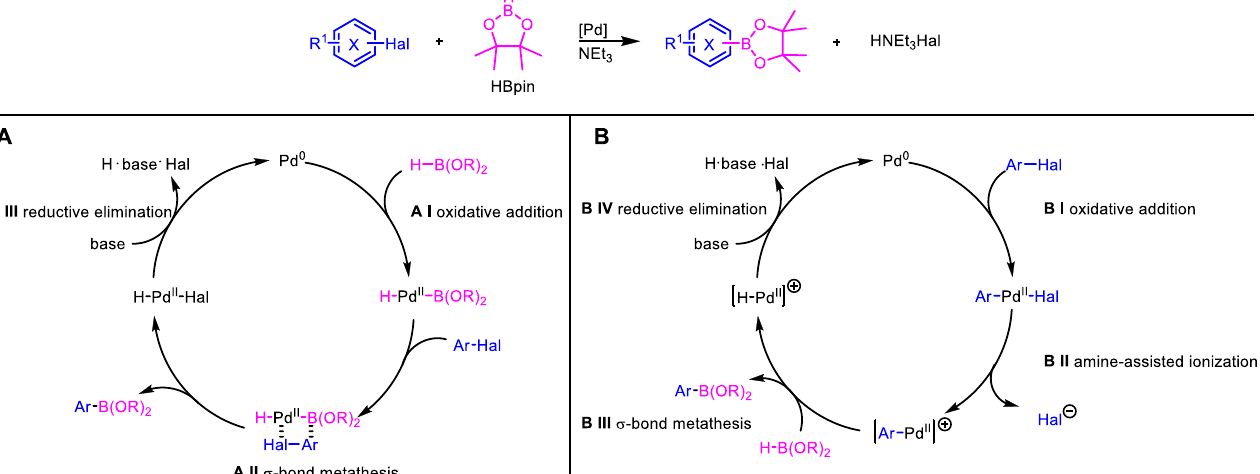
Figure 2. General scheme and proposed mechanisms by Masuda ( A ) and Lin ( B ) of a Masuda boryla- tion.